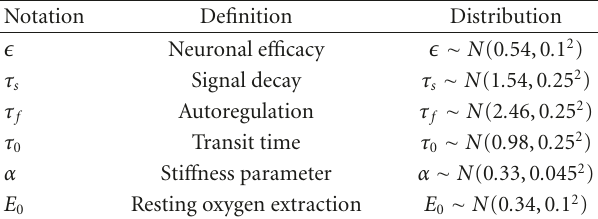
Table 1: Balloon model parameters and their probability distribu- tion. N ( μ , σ 2 ) denotes the normal distribution with mean μ and variance σ 2